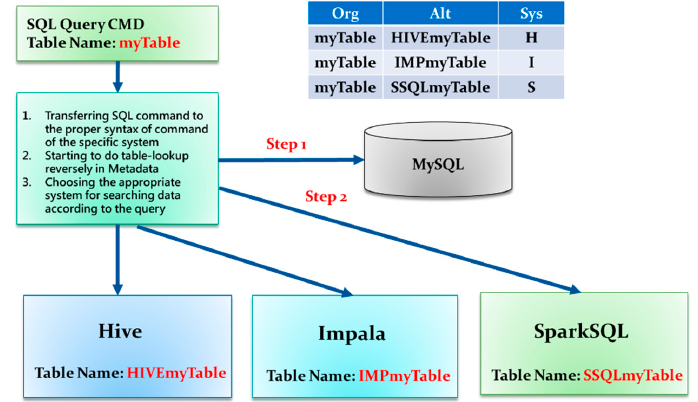
Figure 6. Hive metastore applied to the in ‐ memory cache and the in ‐ disk cache.